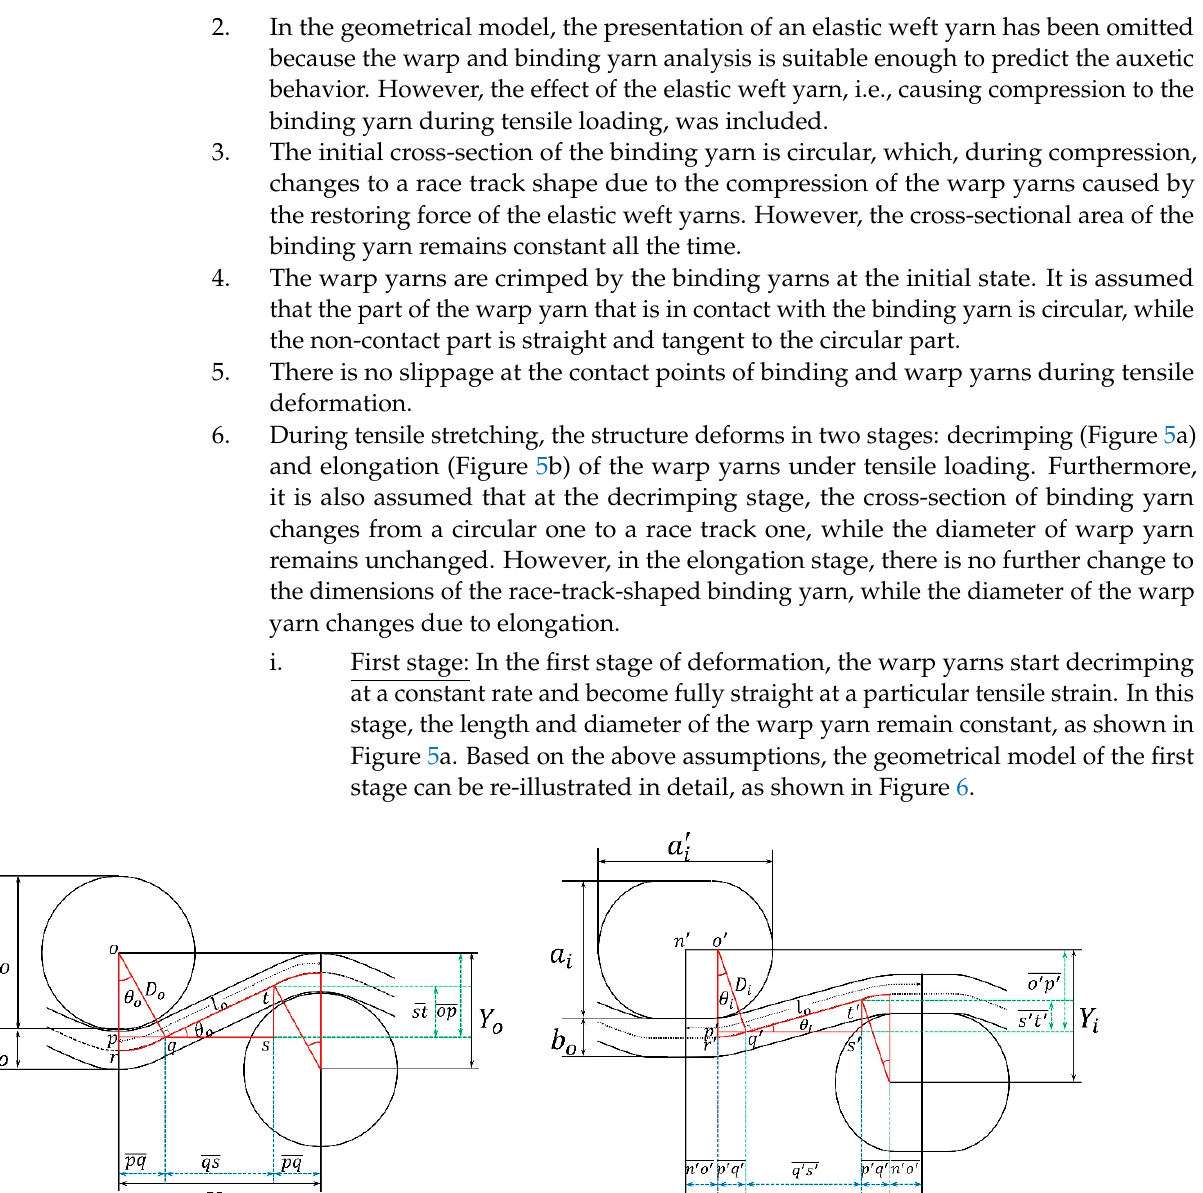
Figure 6. First stage of deformation of a unit-cell: ( a ) initial state; ( b ) deformed state. From Figure 6, the initial distance ( X o ) between the centers of two binding yarns is given by: